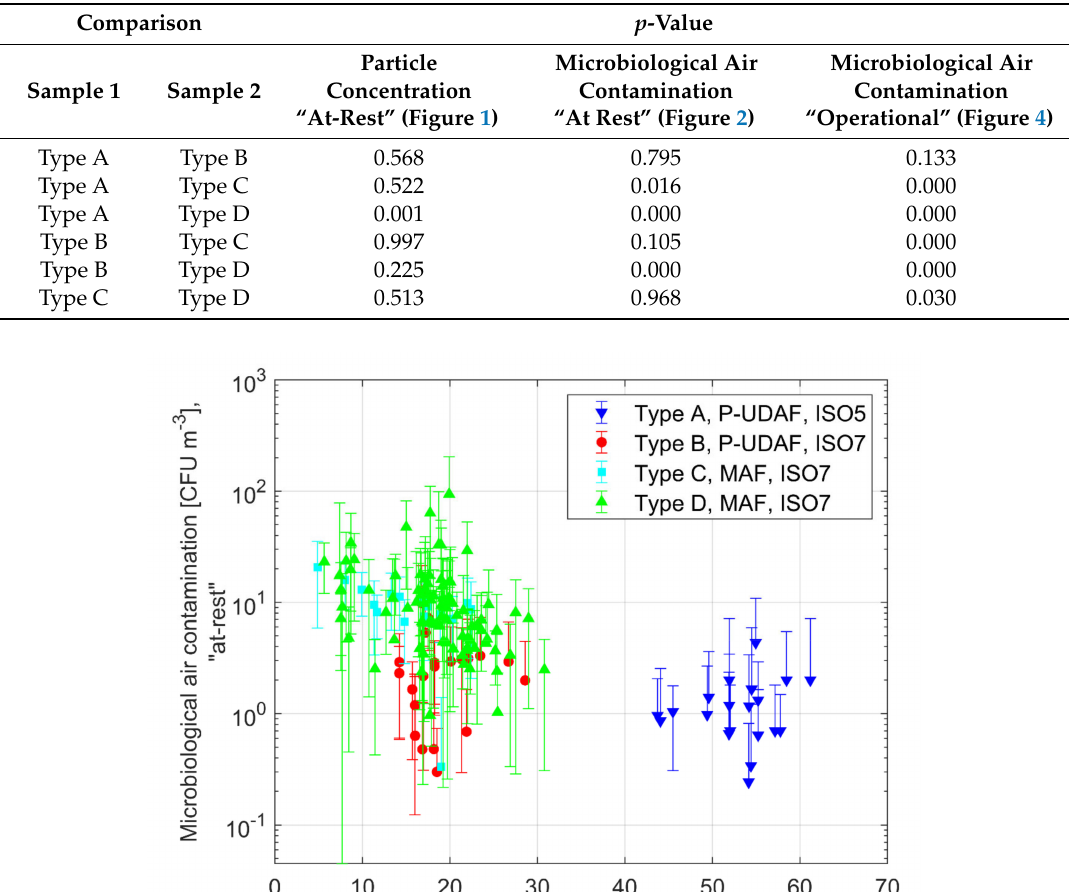
Table 5. Results of comparison between multiple OTs samples. The comparisons are referred to the 175 investigated OTs in terms of particle concentration “at-rest” and microbiological air contamination “at-rest” and “operational”.